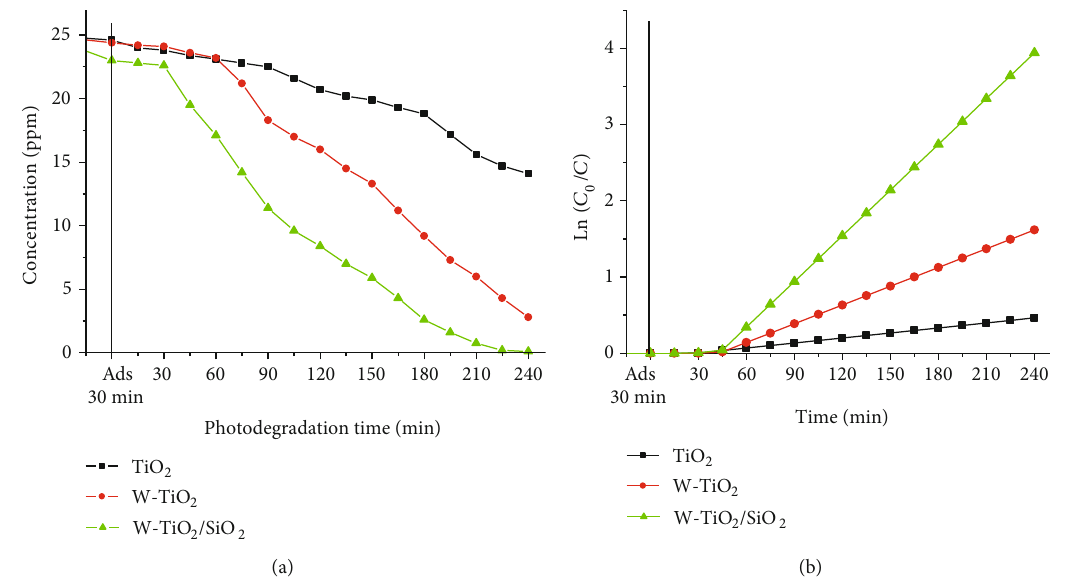
Figure 9: (a) Plots of p -nitrophenol concentration as a function of irradiation time in the presence of TiO catalysts; (b) plots of Ln ð C